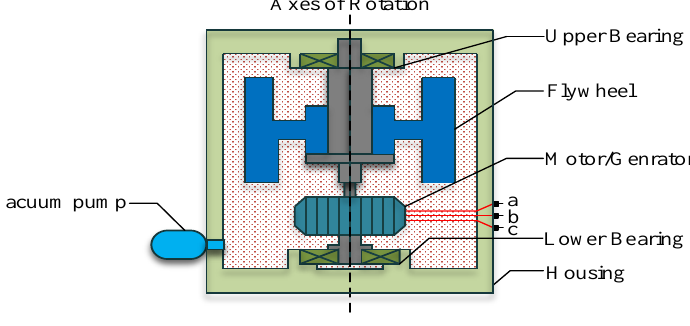
Figure 6. Basic Layout of